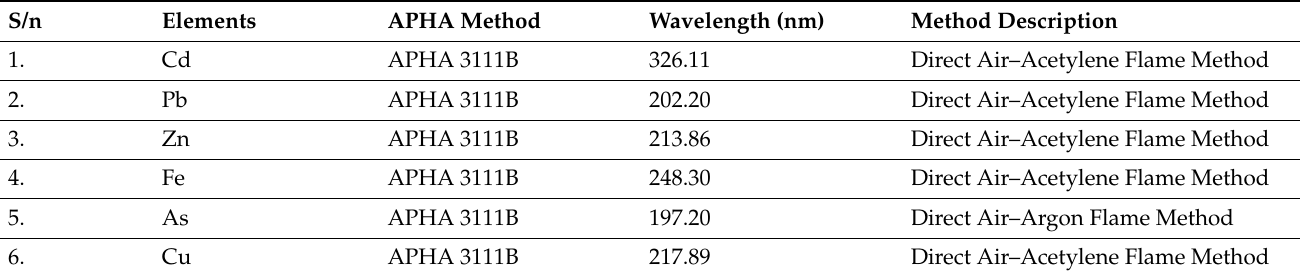
Table 1. Toxic metal analysis